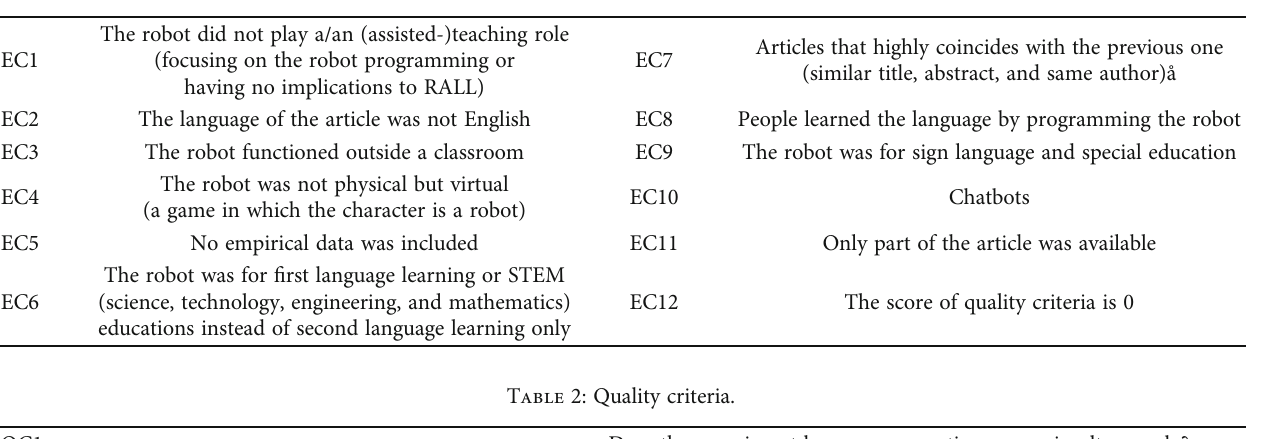
Table 1: Excluded criteria.